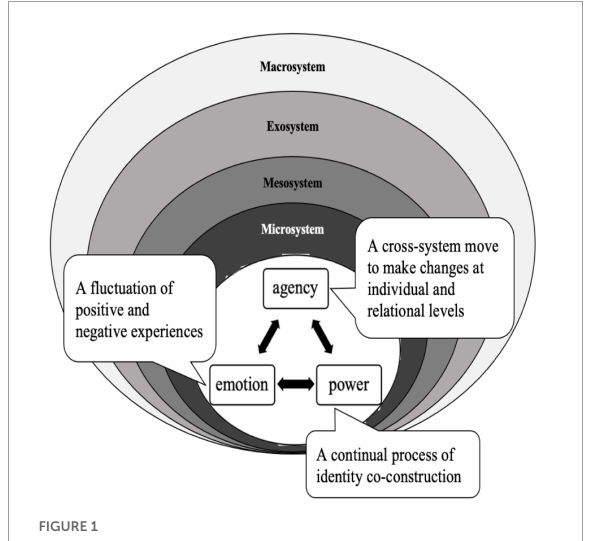
FIGURE1 Emerging teacher leaders’ emotion, agency, and power in reform